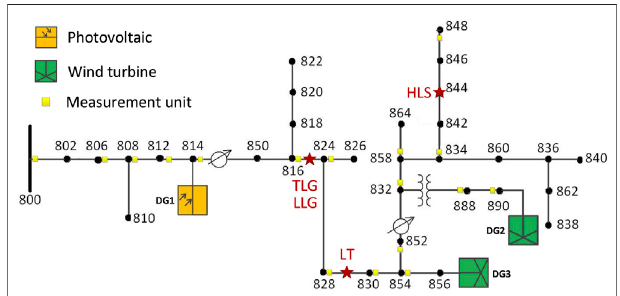
FIGURE 1 | Topology of the IEEE 34-bus system with the integration of